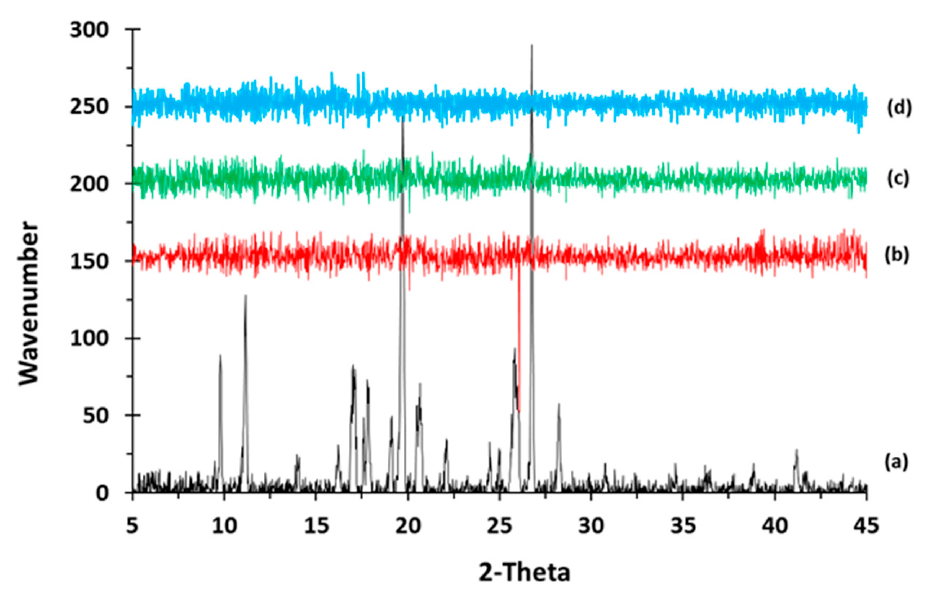
Polymers 2019 , 11 , x FOR PEER REVIEW 7 of 14 Figure 2. X-ray powder diffraction (XRPD) pattern of (a) captopril API (b) F2, (c) F3, and (d) F4. Figure 2. X-ray powder di ff raction (XRPD) pattern of (a) captopril API (b) F2, (c) F3, and (d) F4.